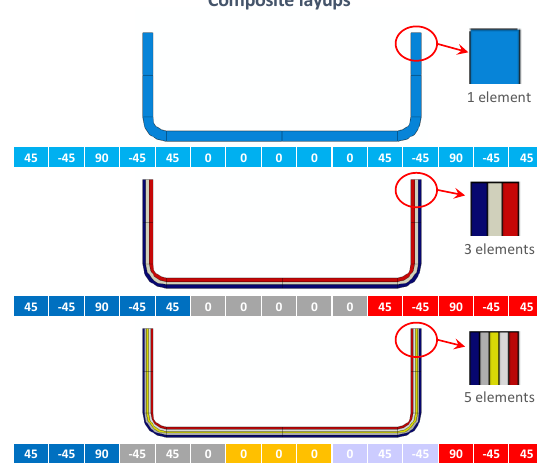
Figure 5. Five elements in the thickness direction: Coarser mesh (Mesh 5A), intermediate mesh (Mesh 5B), and finer mesh (Mesh 5C).